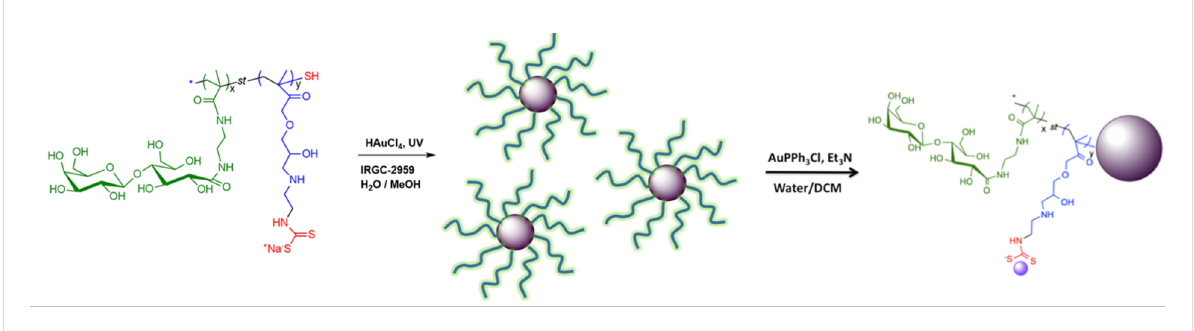
Figure 7: Design of GAuNPs, displaying both sugar residues and the anticancer Au(I)PPh 3 . Reprinted with permission from [88]. Copyright 2014 American Chemical Society.